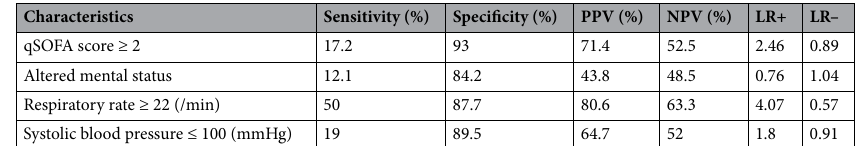
Characteristics